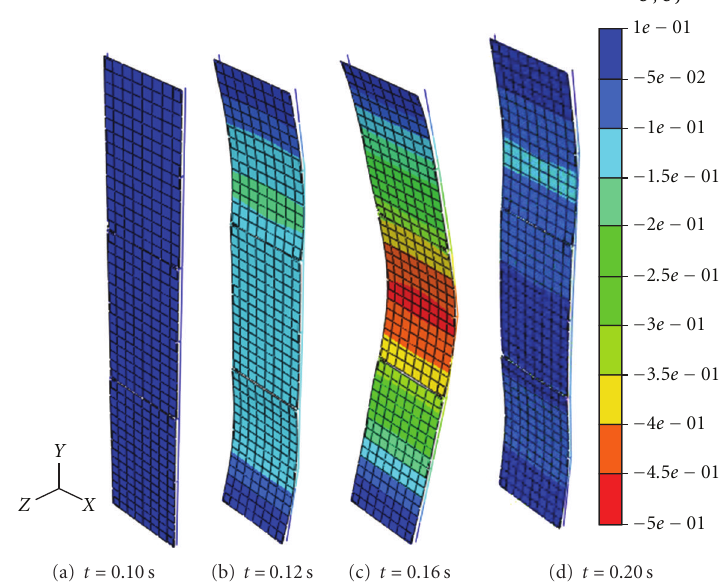
Figure 4: Typical deformed configurations of the fac¸ade-module due to a high-level explosion (Level D-GSA, BL1). M01 FE-model.